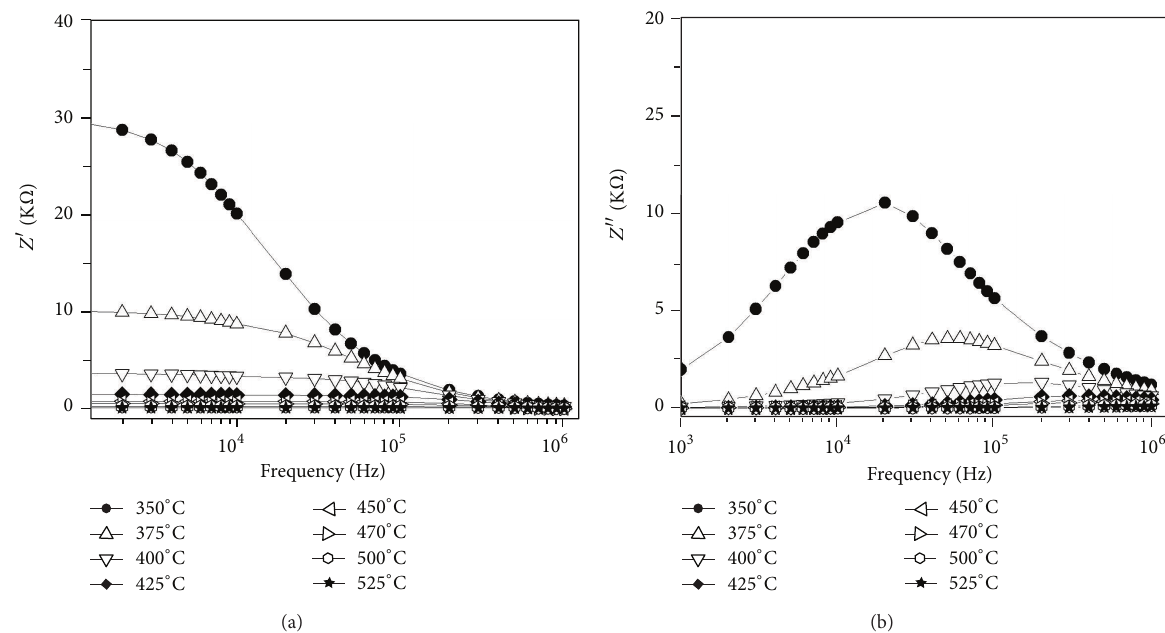
Figure 4: (a) Plot of real part of impedance ( 𝑍 󸀠 ) with frequency. (b) Plot of imaginary part of impedance ( 𝑍 󸀠󸀠 ) with frequency.